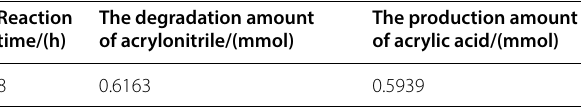
Table 1 The degradation amount of acrylonitrile to be 0.994, suggesting that the experimental data was and the production amount of acrylic acid correlated well with the first order reaction kinet- ics model. Besides, the k (slope of line) and half-life Reaction The degradation amount The production amount time/(h) of acrylonitrile/(mmol) of acrylic (t 1/2 ) of ZJUTB06-99 was 0.1784 h − 1 and 3.885 h, respectively.